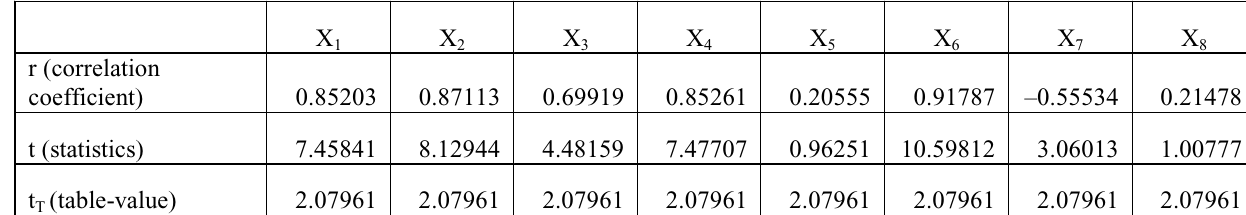
Table 2. Correlation coefficients between OMXV and macroeconomic variables. Values of t-observed and t-critical